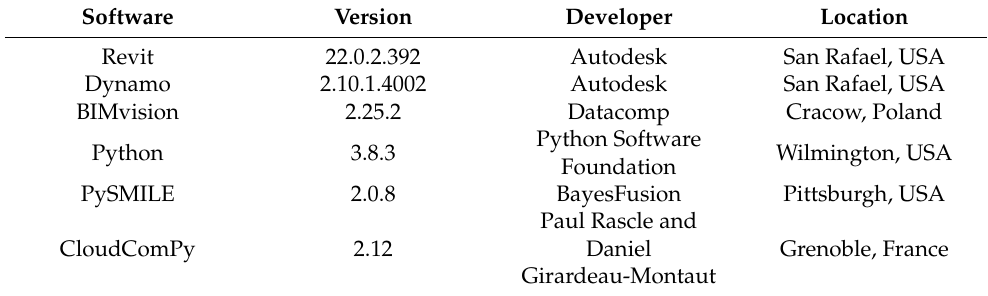
Table 1. Used software for the BIM-based decision support algorithms developed in this research. Software Version Developer